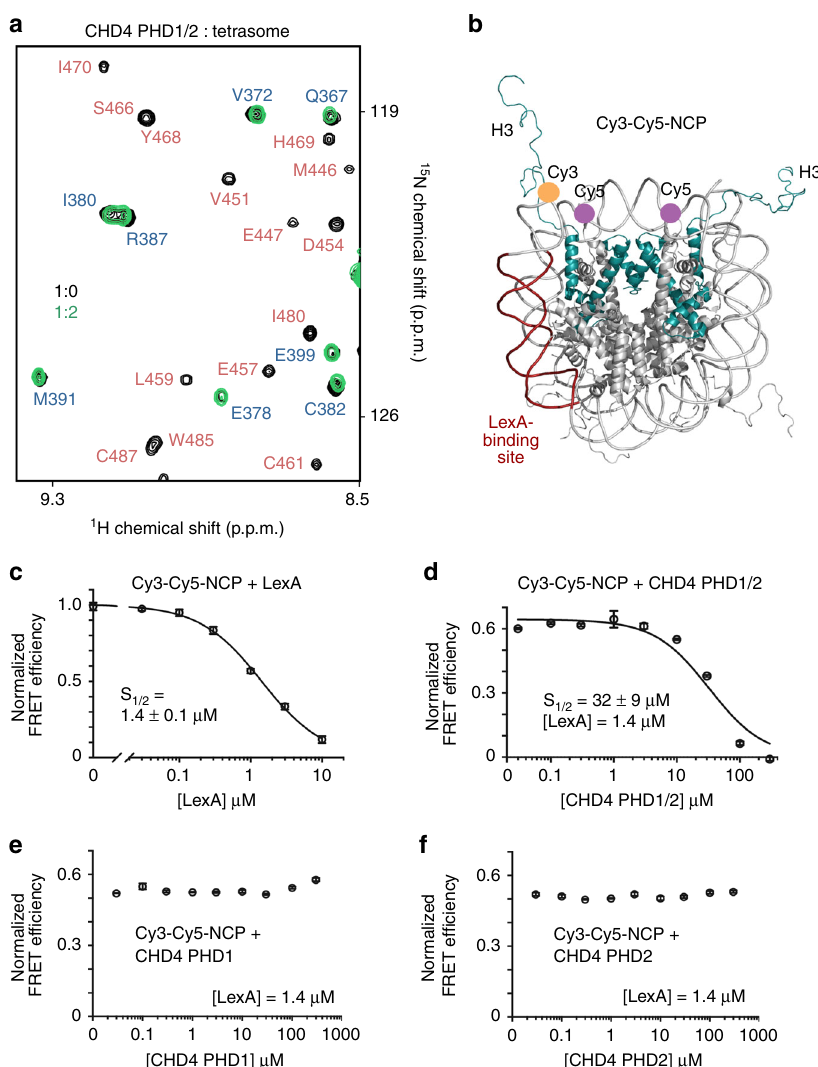
Fig. 4 The effect of DNA and the impact on NCP dynamics. a Superimposed 1 H, 15 N HSQC spectra of CHD4 PHD1/2 recorded with and without tetrasome. b Crystal structure of the NCP (PDB ID: 1KX5) with H3 (cyan ribbon), Cy5 at H2AK119C (purple circle), Cy3 at the 5 prime end of 601 L (orange circle), and the LexA target site (brick red) are shown and labeled. c FRET ef fi ciency (E) of the Cy3-Cy5 labeled nucleosomes with increasing concentration of LexA (0 – 10 μ M). LexA binds to its target site and traps the nucleosome in a partially unwrapped state, resulting in a decrease in FRET as [LexA] increases. The LexA titration data were fi t to a binding isotherm with an S 1/2 = 1.4 μ M. ( d – f ) FRET ef fi ciencies of the Cy3-Cy5-NCP upon titration with CHD4 PHD1/2, PHD1 or PHD2 in the presence of 1.4 μ M of LexA. Error bars represent SD based on three